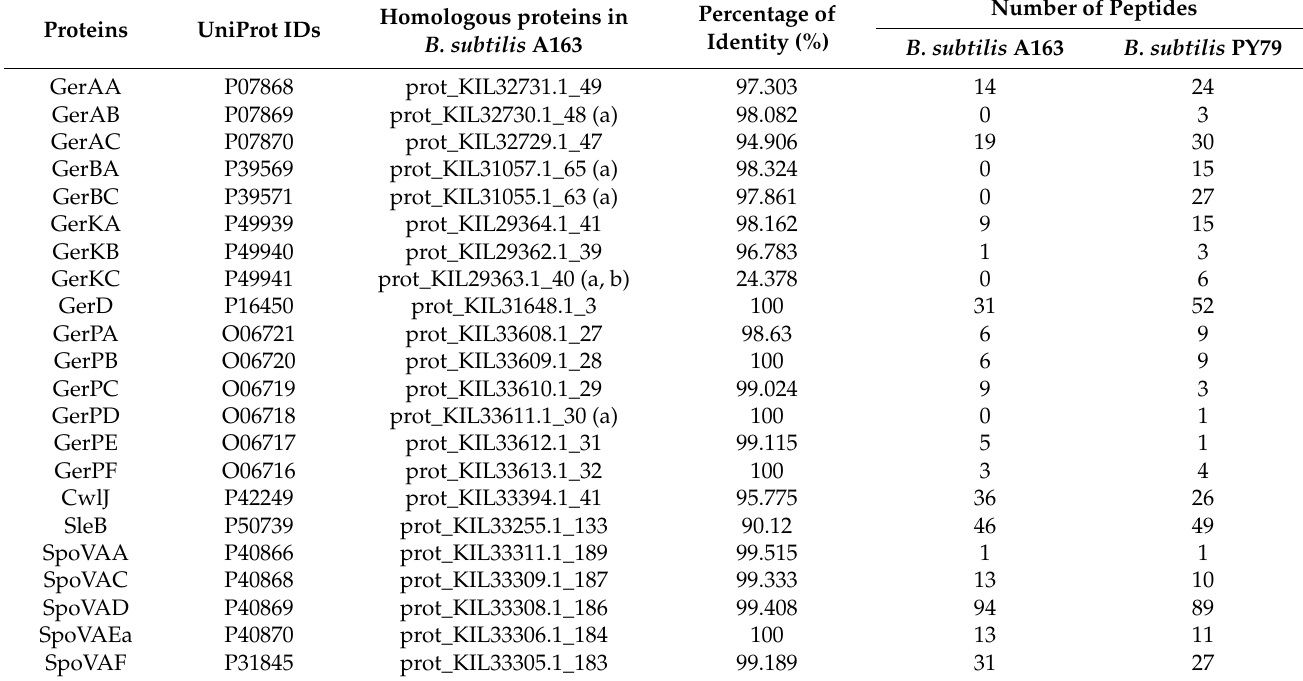
(a), not identified in the spore proteome, but showing a high percentage of identity with the protein; (b), low percentage of identity, more research is